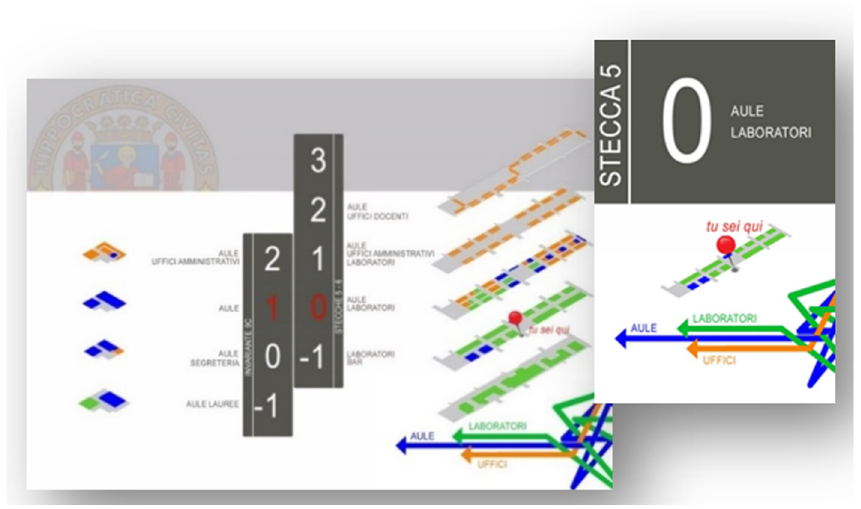
Figure 10. Signposting to secondary nodes: placed in correspondence of spaces accessible from outside and near lift.